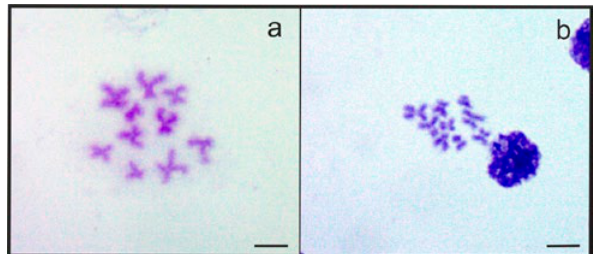
Fig. 5. (a.-b) Metaphase II plates (a) Haploid set with X chromo- some (b) Haploid set with minute y chromosome which cannot be seen Bar =